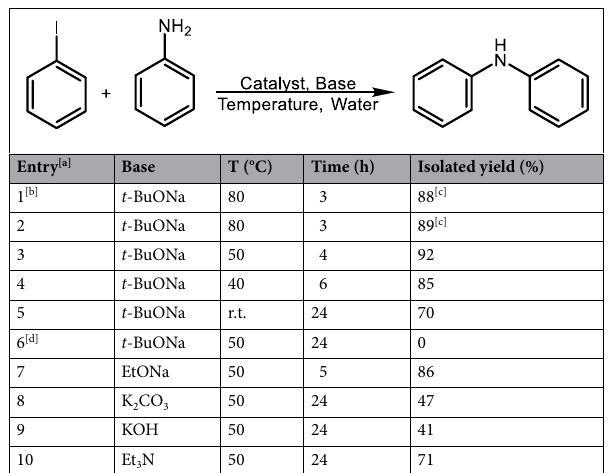
Table 5. Buchwald–Hartwig amination reaction of iodobenzene with aniline catalyzed by γ-Fe 2 O 3 @MBD/ Pd-Co under different conditions in water. [a] Reaction conditions: iodobenzene (1 mmol), aniline (1.2